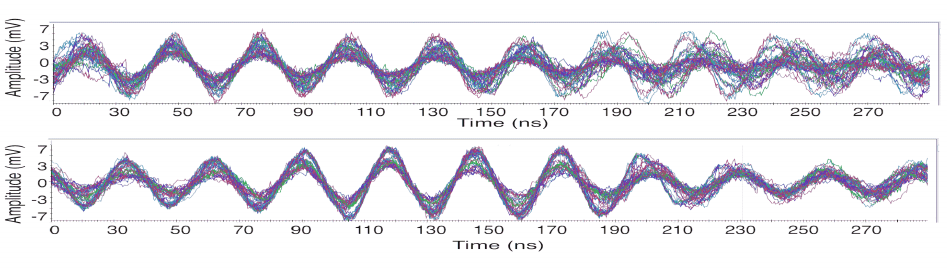
Figure 26: Aligned template traces for scalar assignment protected (top) and unprotected (bottom)